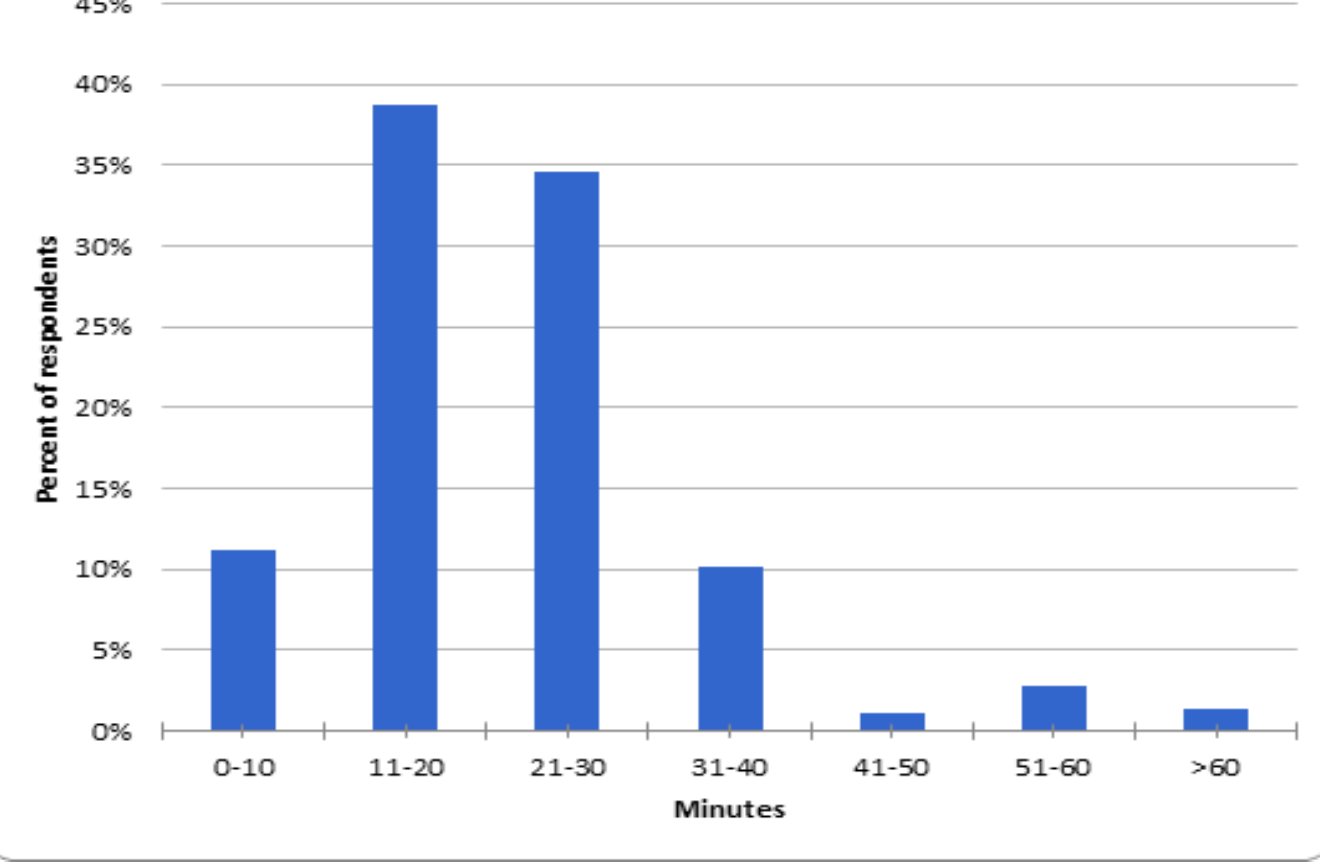
Figure 1. Resident perception of the ideal length of time for an emergency medicine podcast or podcast